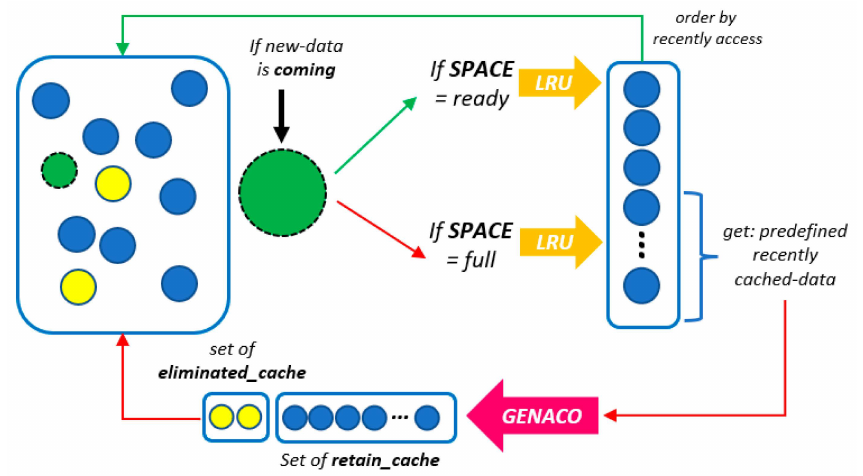
Figure 2. The proposed LRU-GENACO